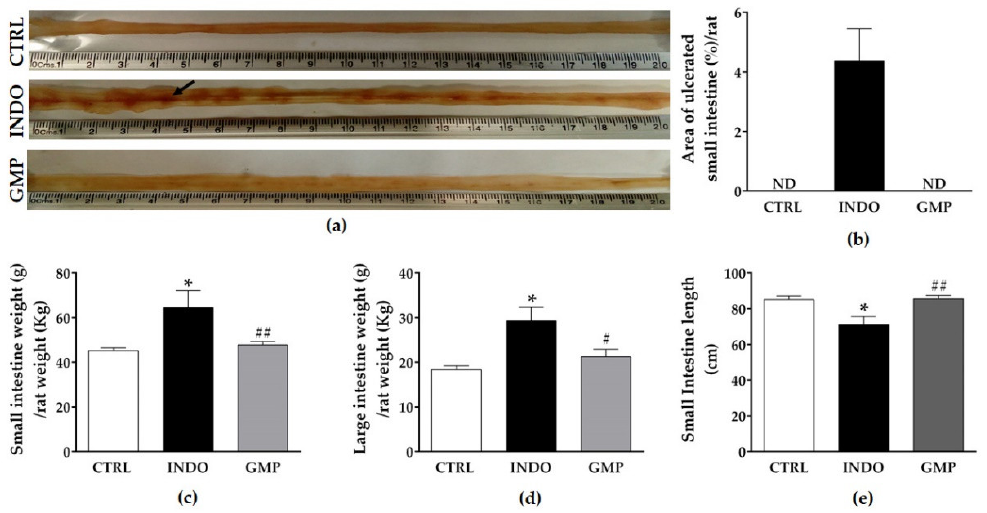
Figure 2. Effect of treatment with glycomacropeptide (GMP) on intestinal damage, weight and length in rats with indomethacin-induced enteropathy. ( a ) Representative pictures of the mucosal surface of the small intestine of rats from the CTRL, INDO and GMP groups. The arrow indicates ulcerative lesions. ( b ) Intestinal damage in rats presented as percentage (%) of area of ulcerated small intestine. Small ( c ) and large ( d ) intestine weights in relation to rat body weight. ( e ) Small intestine length of animals from experimental groups. Data are presented as mean ± SEM. CTRL and GMP, n = 14; INDO, n = 11. * p < 0.01 INDO vs. CTRL; # p < 0.05 and ## p < 0.01 GMP vs. INDO. ND: not detected.